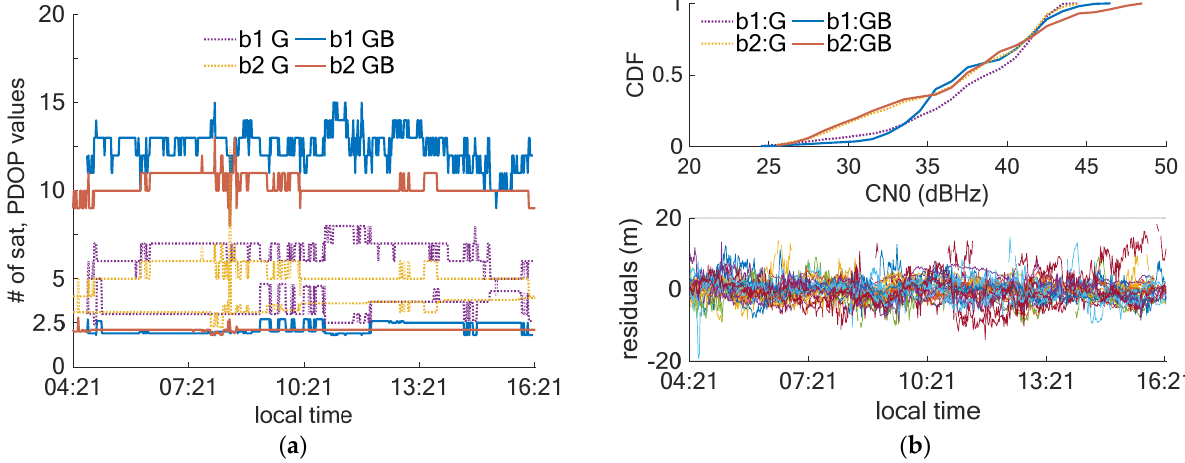
Figure 6. ( a ) Observed satellite number, PDOP values. ( b ) C/N0 cumulative distribution function (CDF), residuals for group 1.5 m in the degraded environment.